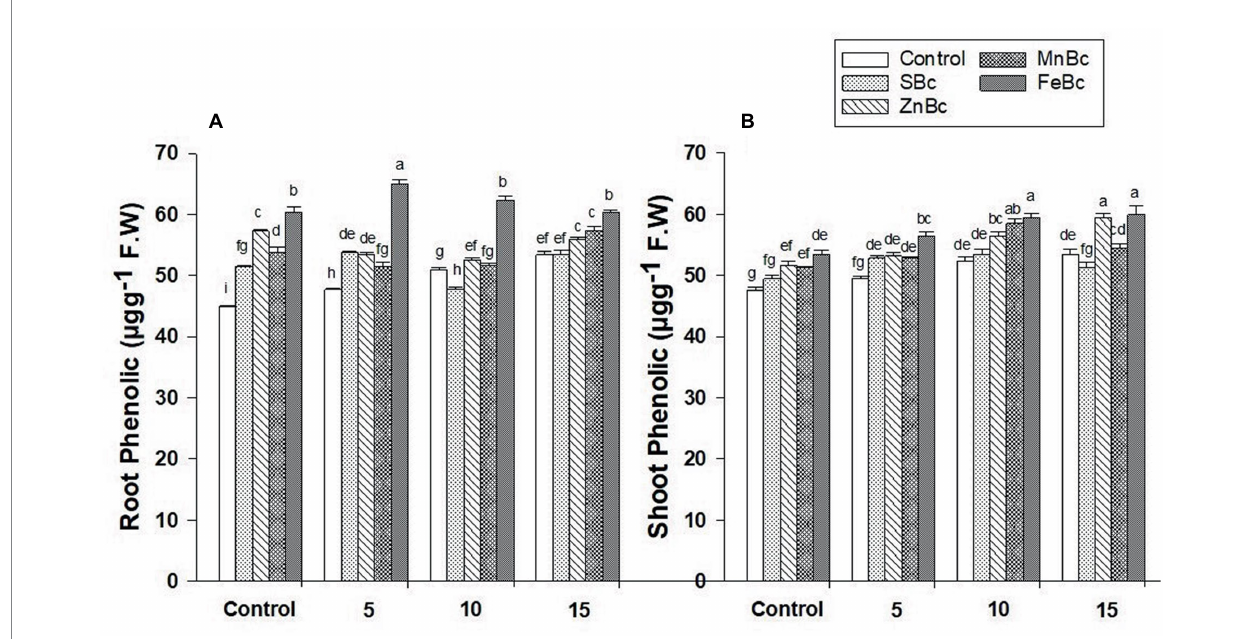
FIGURE 6 (A) Root Phenolic and (B) Shoot Phenolic of T. aestivum L. grown under various treatments such as T1 = DW, T2 = DW + 0.1% SBc, T3 = DW + 0.1% ZnBc, T4 = DW + 0.1% MnBc, T5 = DW + 0.1% FeBc, T6 = 5dSm − 1 BW, T7 = 5dSm − 1 BW + 0.1% SBc, T8 = 5dSm − 1 BW + 0.1% ZnBc, T9 = 5dSm − 1 BW + 0.1% MnBc,